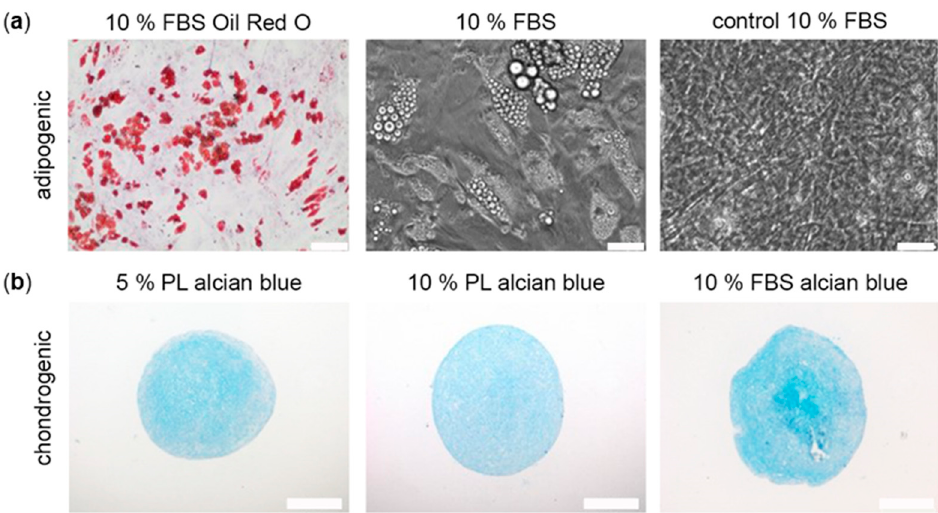
Figure 3. Effect of PL and FBS substitution on ADSC differentiation. ( a ) Representative images of FBS groups after adipogenic differentiation in Oil Red O staining and in phase contrast and of control groups in phase contrast. ( b ) Representative images of chondrogenic differentiated ADSC in alcian blue staining from day 28. Scale bar 200 µm.